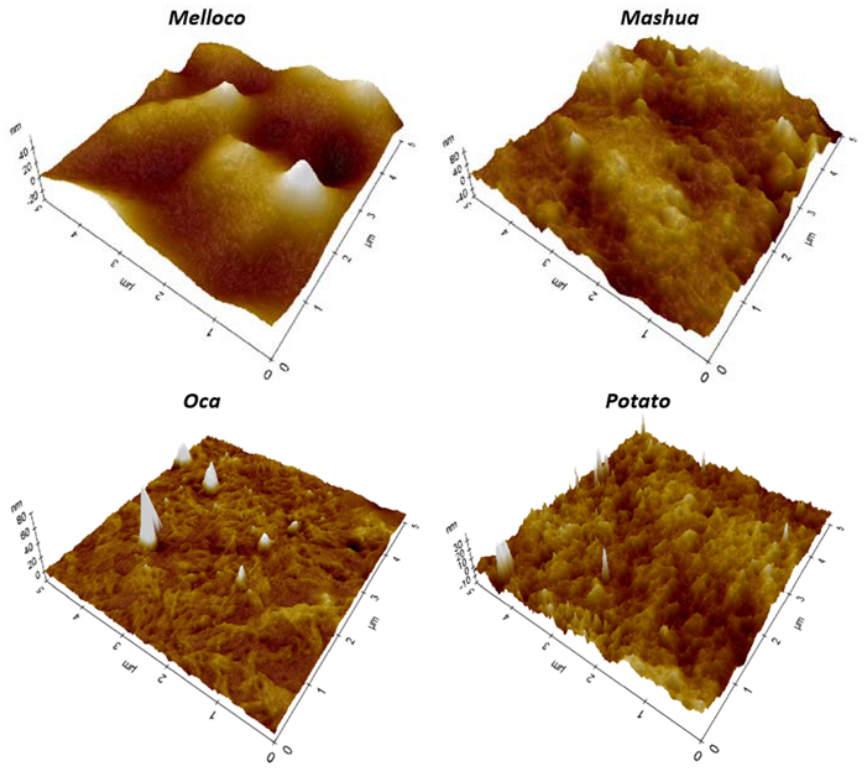
Figure 6. Tridimensional topographic atomic force microscopy comparison among 5 µ m side squared images of biofilms extracted from each Andean tuber analyzed.